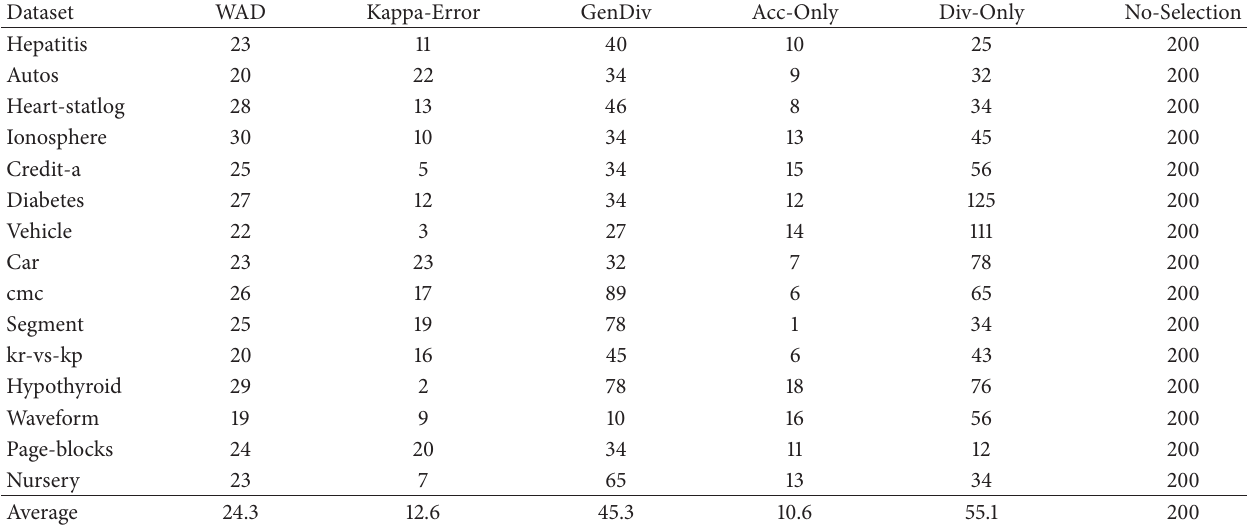
Table 3: The average size of ensembles selected by candidate measures and GA.